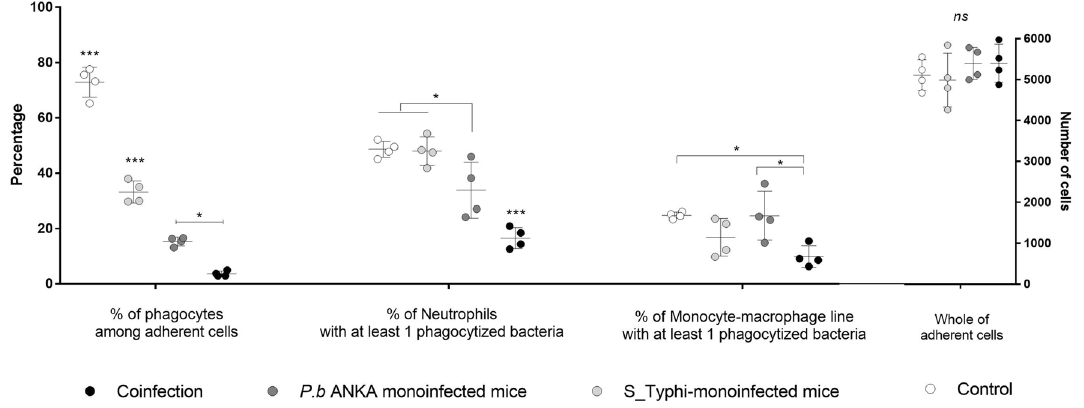
Figure 3. Evaluation of phagocytic activity of ex vivo medullar neutrophils and macrophages. After 24 h of ex vivo incubation on glass slides of cells recovered from the femur of anesthetized mice from coinfected, monoinfected groups with P. berghei ANKA or S_Typhi and control group. After washing, the adherent cells were incubated with Phorbol 12-myristate 13-acetate (PMA) for activation in the phagocytosis assay. A suspension of S_Typhi killed by formalization was incubated with the adherent cells. Finally, the slides were washed, fixed in picric acid and stained using the Romanowsky method. Neutrophils and monocytes were visualized through staining characteristics and the total number of phagocytic bacteria was calculated. The phagocytic activity in cells between groups was compared using the percentage of phagocytes between adherent cells; % of neutrophils and % of macrophage containing phagocytic bacteria, respectively. The phagocytic activity in cells was compared by multiple comparison by Tukey’s method. The data are shown in a scattered plot with mean and standard deviations. Asterisks: level of significance of * p < 0.05, ** p < 0.005 and *** p <